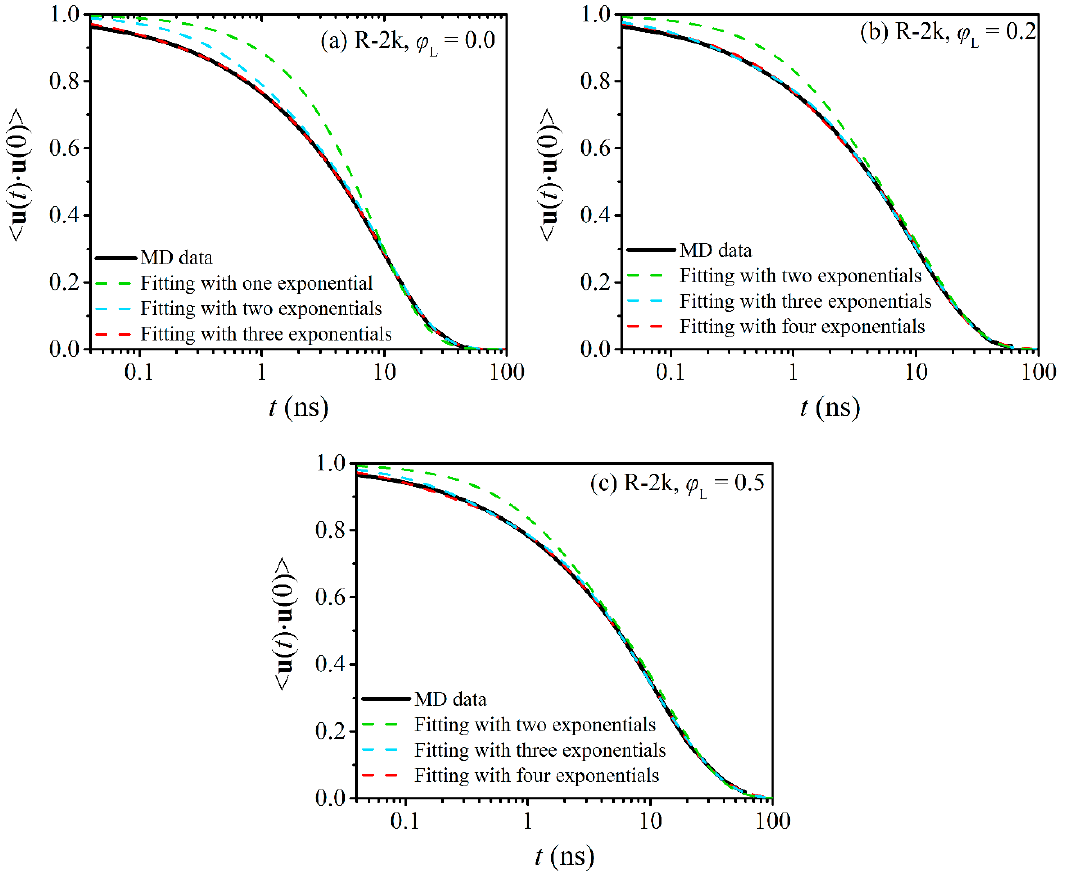
(cid:10) (cid:11) ( ) ( ) u ( t ) · u ( 0 ) describing relaxation at the level of the ⋅ t 0 u u